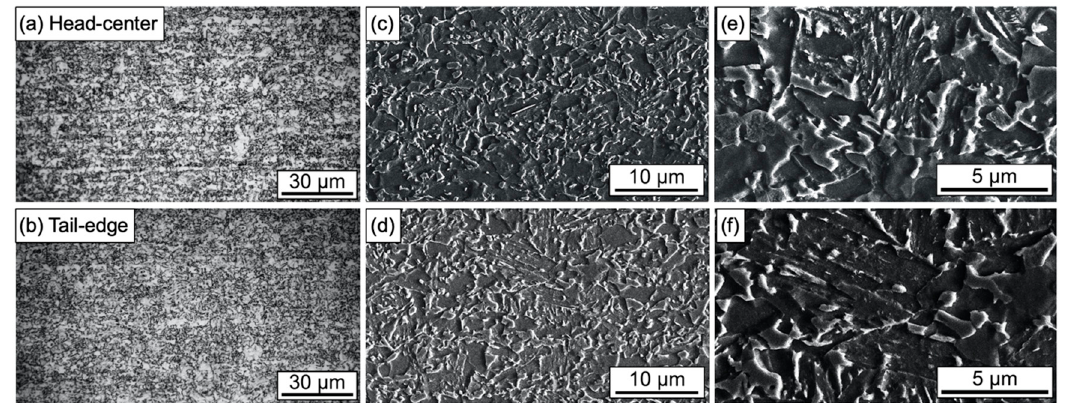
Figure 5. Microstructure of as-hot rolled steel in batch annealed condition: ( a , b ) light optical microscopy; ( c , d ) transmission electron microscopy.